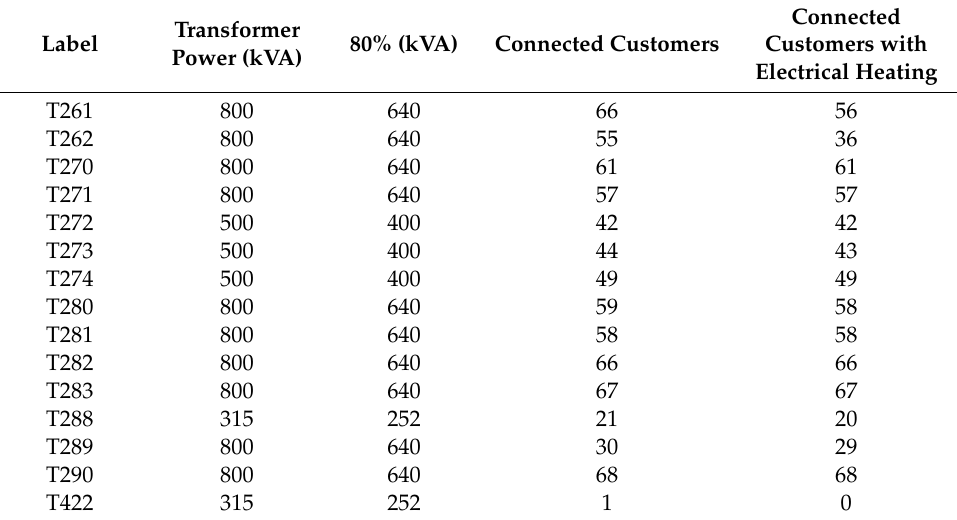
Table 1. The various transformers of the